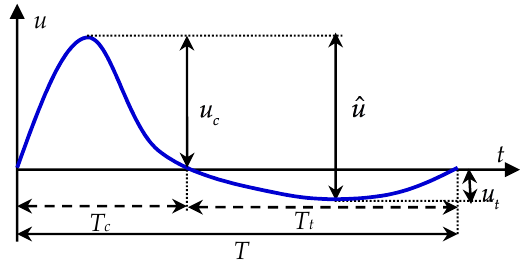
Figure 3. Definitions of variables for an asymmetric velocity profile.